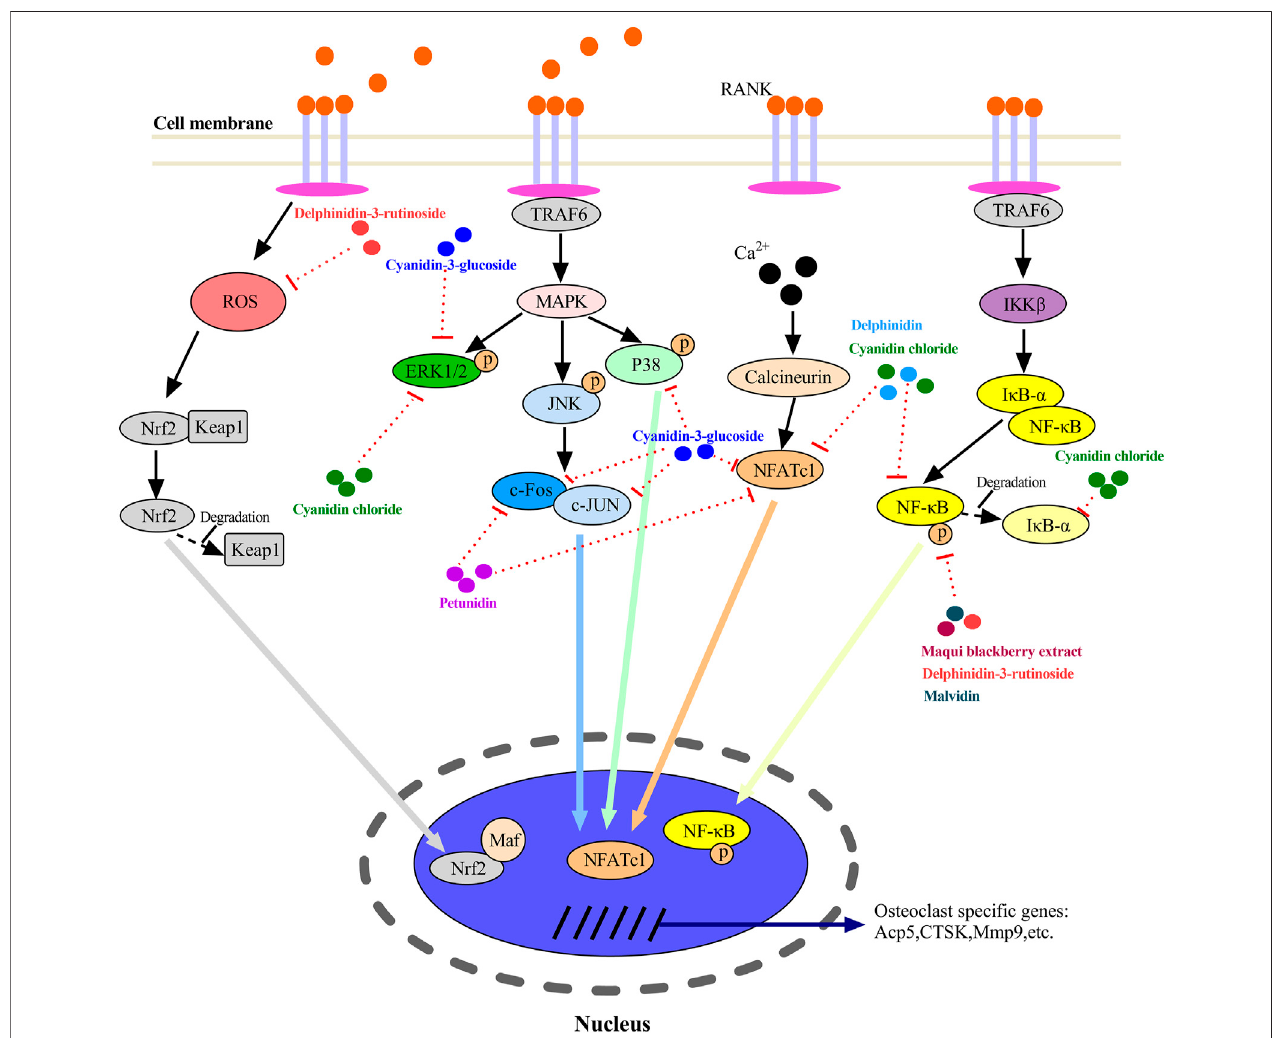
FIGURE 2 | A proposed working model for the inhibition of anthocyanins on osteoclastogenesis.